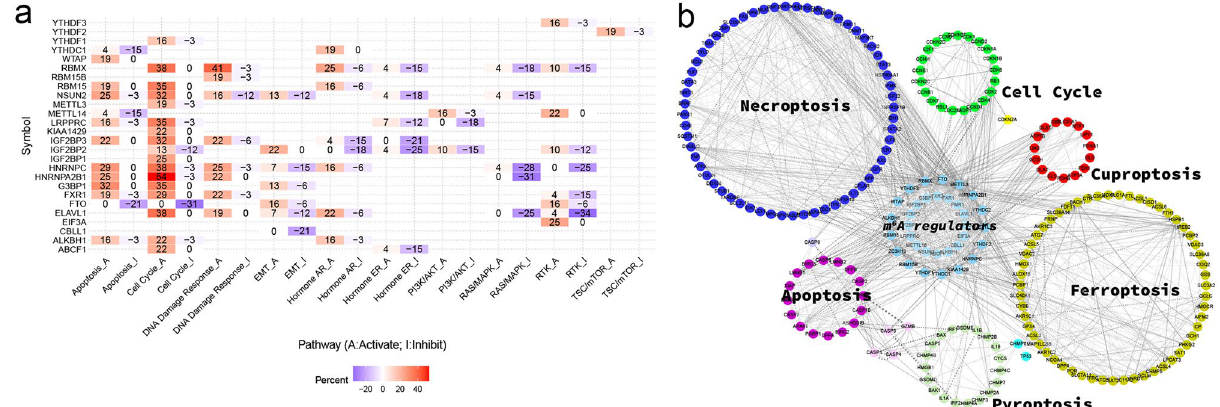
Figure 8. Correlation analysis of m6A regulators with cell cycle and programmed death. ( a ) The essential pathway enrichment analyses of 33 m 6 A regulators by GSCA. ( b ) The correlation network between m 6 A regulators and programmed death genes of interest, which including cell cycle, apoptosis, pyroptosis, necroptosis, ferroptosis and cuproptosis (|R|> 0.3 and P < 0.05). Solid lines represent positive correlations, dashed lines represent negative correlations. The thicker the line, the stronger the correlation between the two